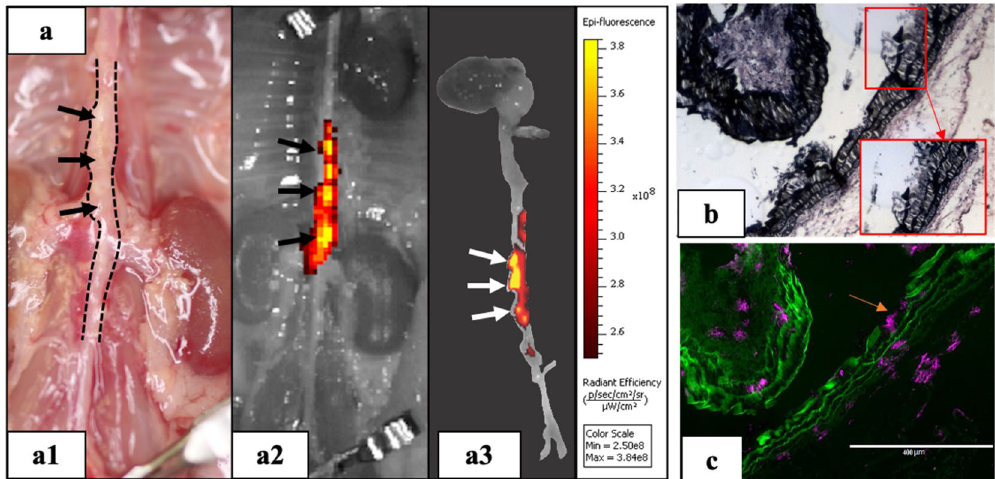
Figure 2. DiR-NPs targeting in Ang II mouse model. ( a ) In-vivo targeting study using DiR loaded nanoparticles (DiR-NPs). DiR NPs were injected via tail vein and after 24 h animals were euthanized d to assess the targeting. The signal given by the DiR-NPs in the IVIS images (a2,a3) indicated that DiR-NPs only accumulate at the suprarenal aortic area where the aneurysm developed (a1), suggesting the successful targeting of the nanoparticles to the aneurysmal tissue; ( b ) VVG staining of the aneurysmal tissue showing elastin damage and ( c ) fluorescent image of the same site showing distribution of the DiR-NPs (purple) within the tissue, indicating that DiR-NPs target the degraded elastin (green autofluorescence) in the aneurysm.